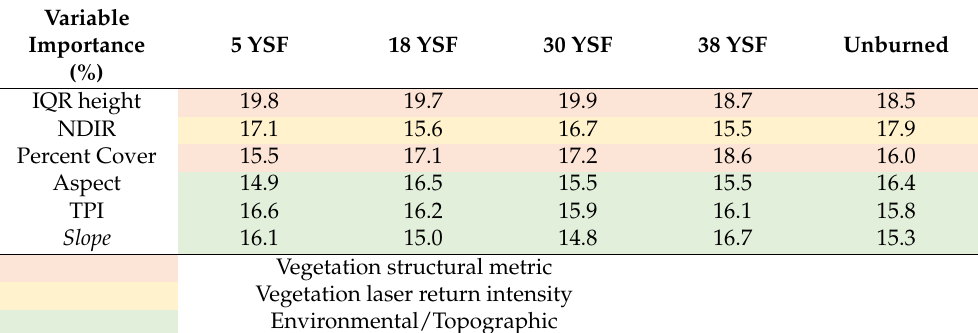
Table 2. Variable importance for each fire chronosequence and unburned area generated using forest-based classification, where YSF refers to years since fire. Here red represents vegetation structural metrics, yellow represents vegetation laser intensity returns, and green represents environ- mental/topographic variables.